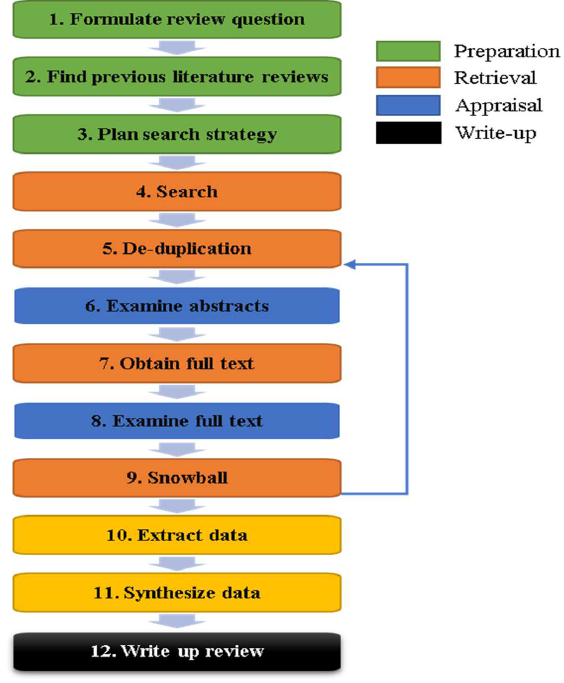
Figure 8. Literature review process steps.